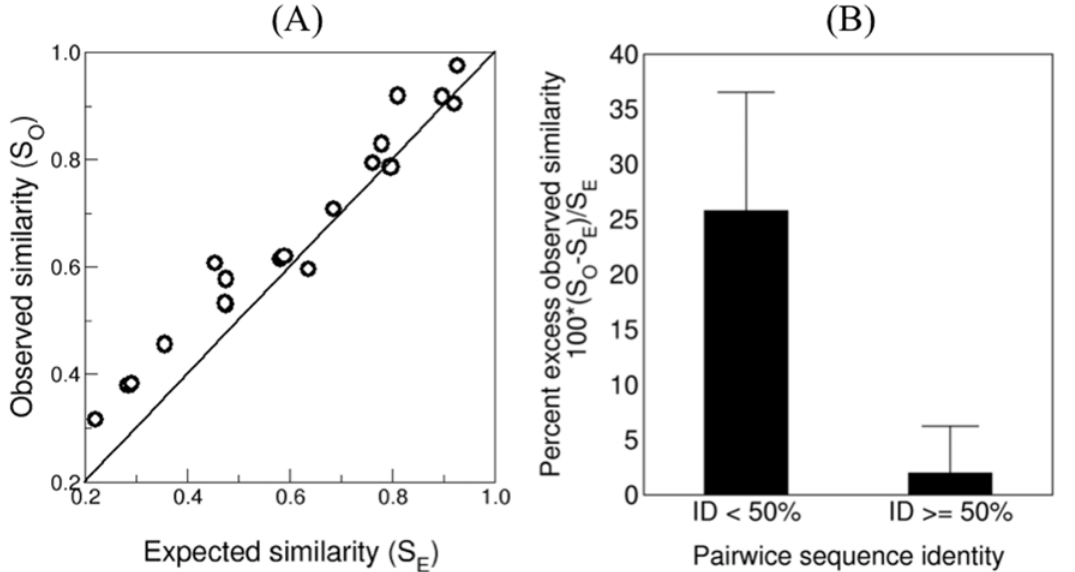
Figure 3. Predicted similarity of pairs of cross-reactive epitopes reported in the literature. (A) The observed similarities S O between 19 cross-reactive epitopes listed in table 1 versus the expected similarities S E (for definitions of S E and S O see the text). The line depicts the diagonal S O =S E . 16 out of 19 points fall above the diagonal. (B) The relative increase of observed similarity with respect to the expected similarity. There is a strong inverse relationship between sequence identity and the level of conservation on non-identical positions. Cross-reactive epitopes with low sequence identity share increasingly conserved amino acids on the remaining positions.